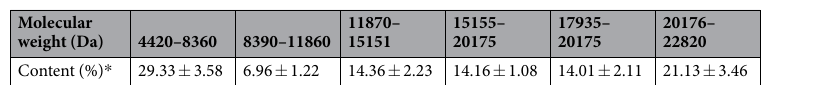
Table 7. Molecular weight distribution of peptides in DSM hydrolysates. * Values were given by mean ± standard (n = 3).